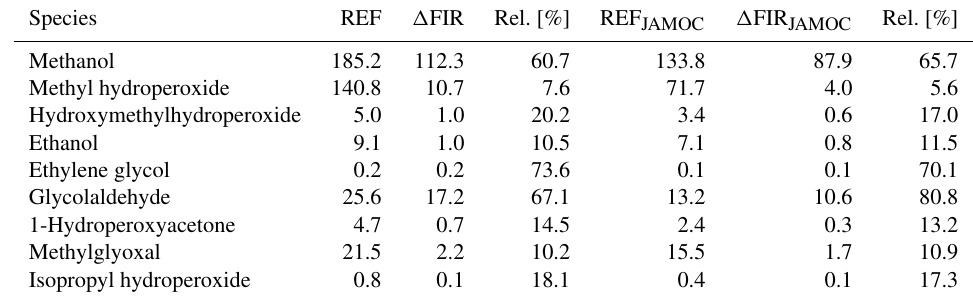
Table 5. The SEA tropospheric burden during the Indonesian fire period with and without VOC biomass burning emissions of OVOCs explicitly reacting in JAMOC. The tropospheric burden is given in gigagrams (Gg). Species REF (cid:49) FIR Rel. [%] REF JAMOC